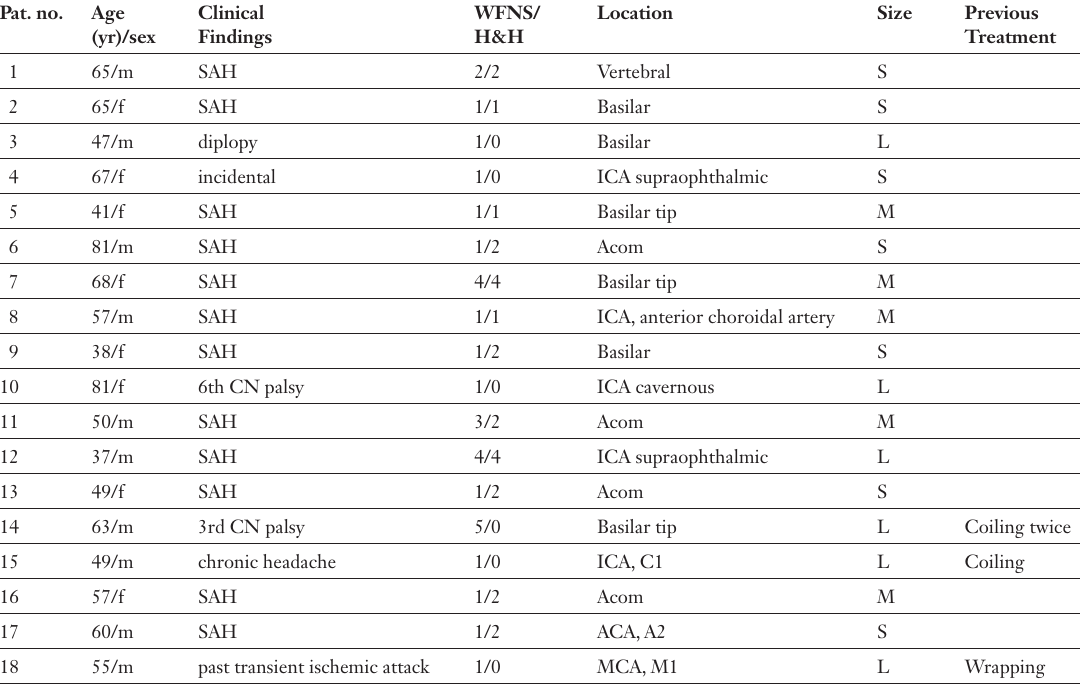
Table 1 Patient data and aneurysm